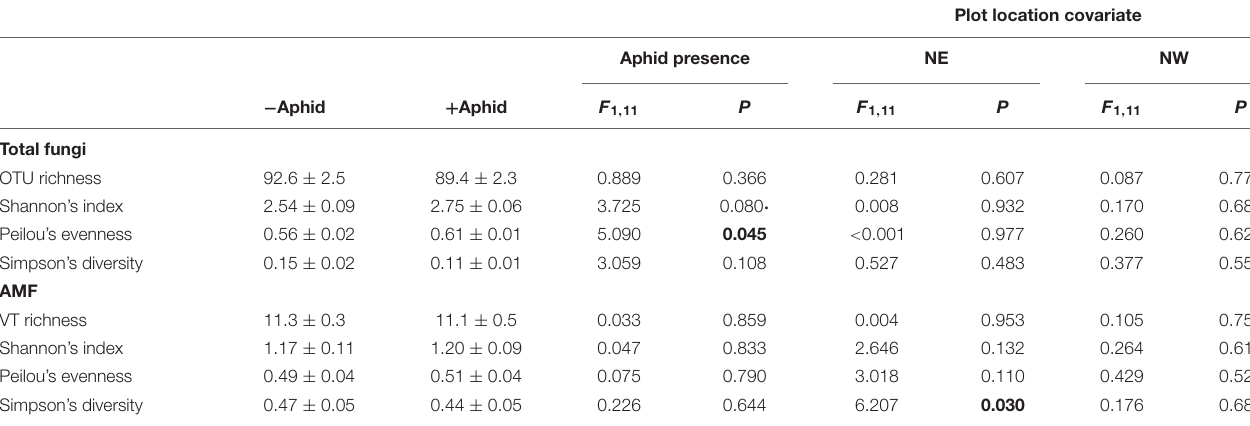
TABLE 4 | Mean ( ± SE) Alpha diversity metrics for “total fungi” amplicon OTUs, and “AMF specific” amplicon VTs from barley plots without or without the presence of aphids, using the location of the plot in the NE and NW direction of the site as a model covariate.